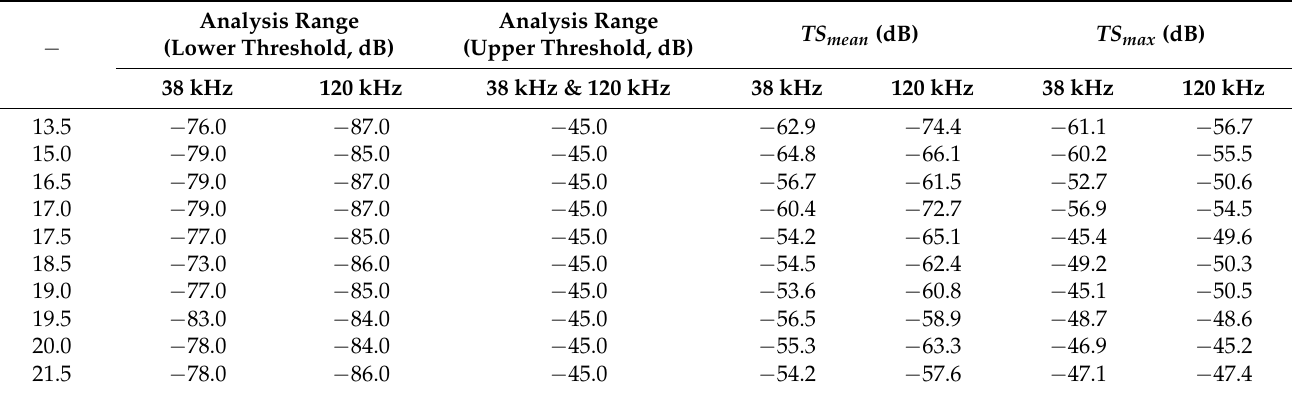
Table 3. Analysis range, mean TS, and max TS for each body length